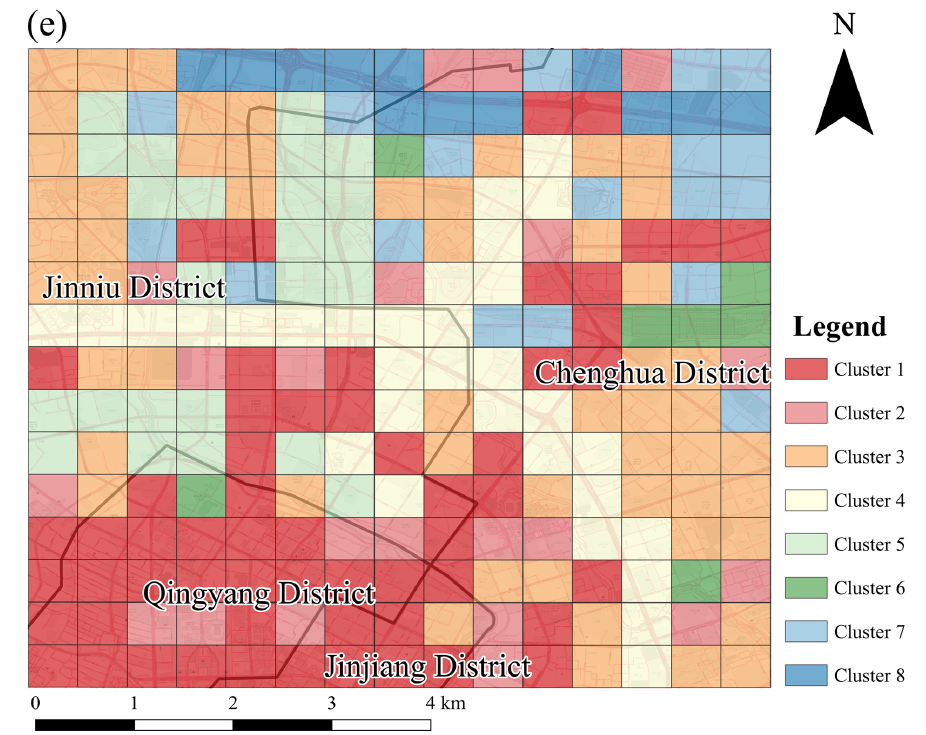
Figure 8. Results of spatial clustering. Subplots ( a – e ) represent the results of spatial partitioning into 4 to 8 classes, respectively.